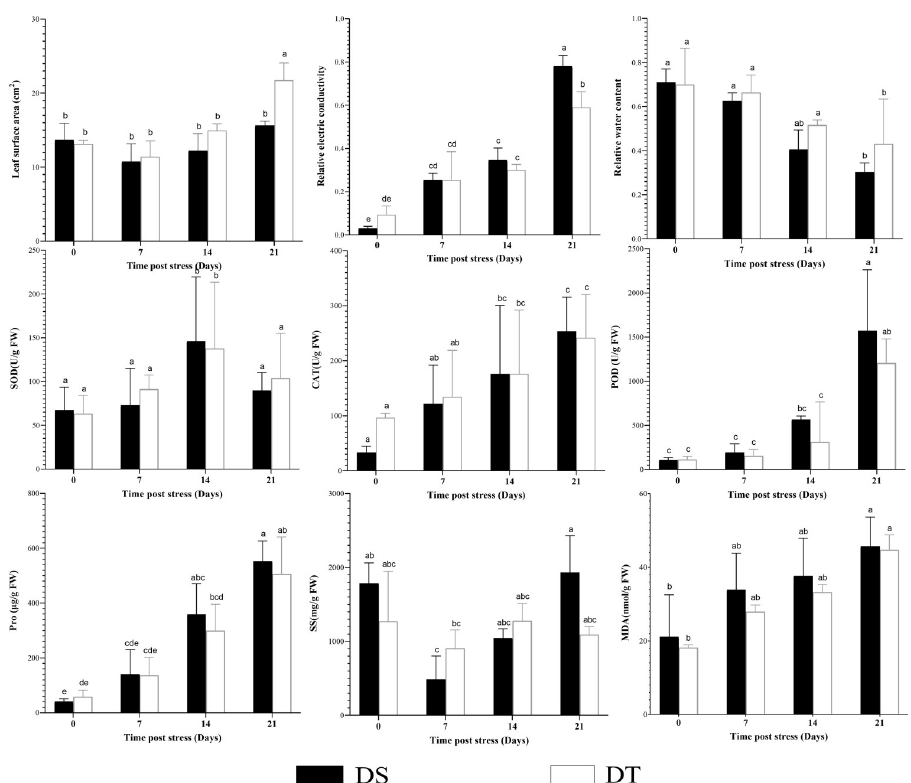
Fig 1. Physiological and biochemical traits of DS and DT under drought stress. Error bars denote standard error of the mean. Significant differences between samples at p � 0. 05 were denoted by different letters.